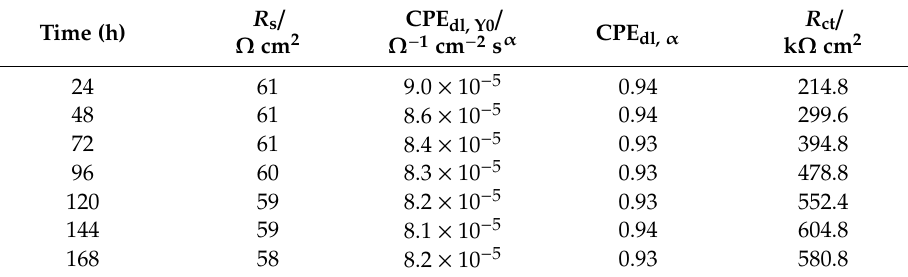
Table 1. Values of electric elements calculated for EEC of blank Ni coating.